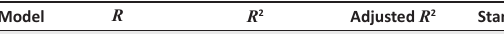
TABLE 5: Model summary of the regression.